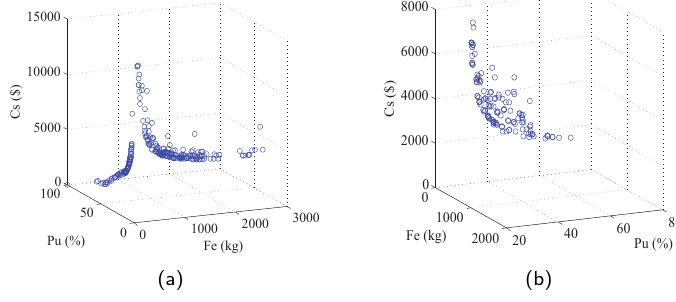
Figure 6. Optimal solutions for HRES in different modes. ( a ) mode I; and ( b ) mode II.